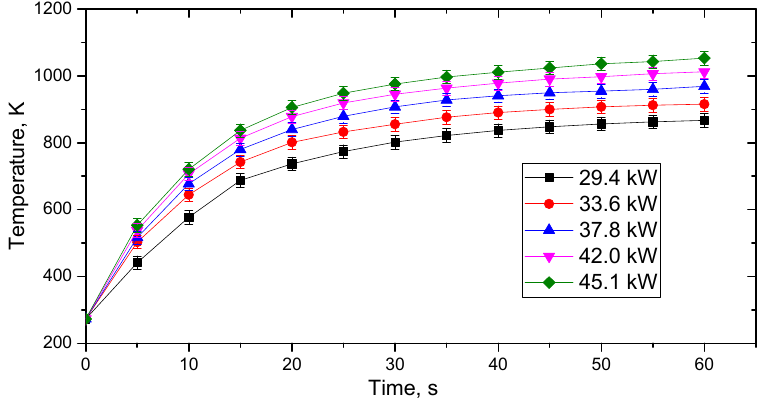
Figure 4. Sample temperature during the coating process.